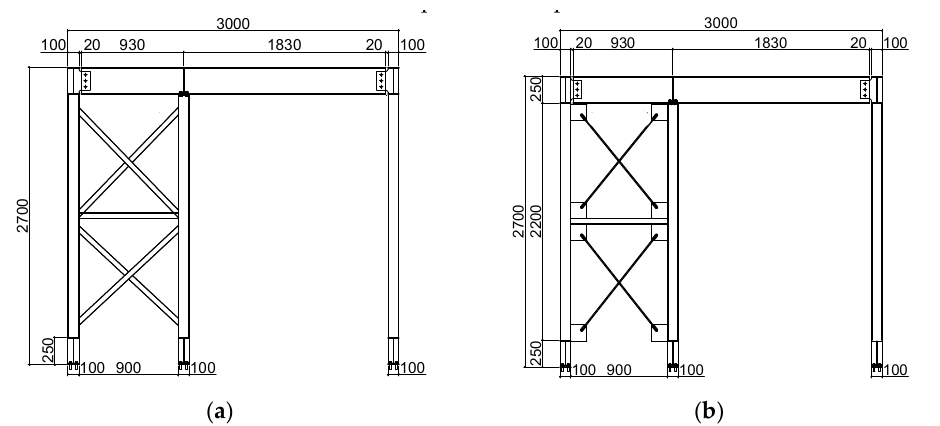
Figure 3. Schematic drawings of test specimens: ( a ) Rigid bracing; ( b ) Flexible bracing. (Unit: mm). Table 1. Details of specimens. Specimen No.